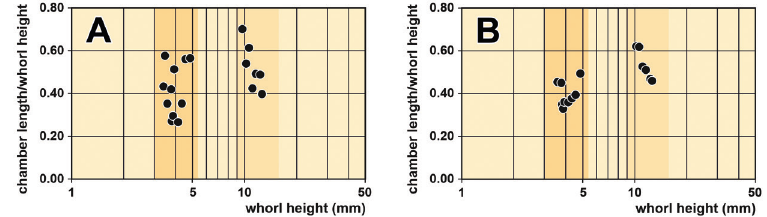
Fig. 62. Lituites nebeni sp. nov., chamber length/whorl height of holotype MB.C.30541 (Neben Coll.) from Niederfinow (Brandenburg, Germany). A . Empirical data. B . Three data point